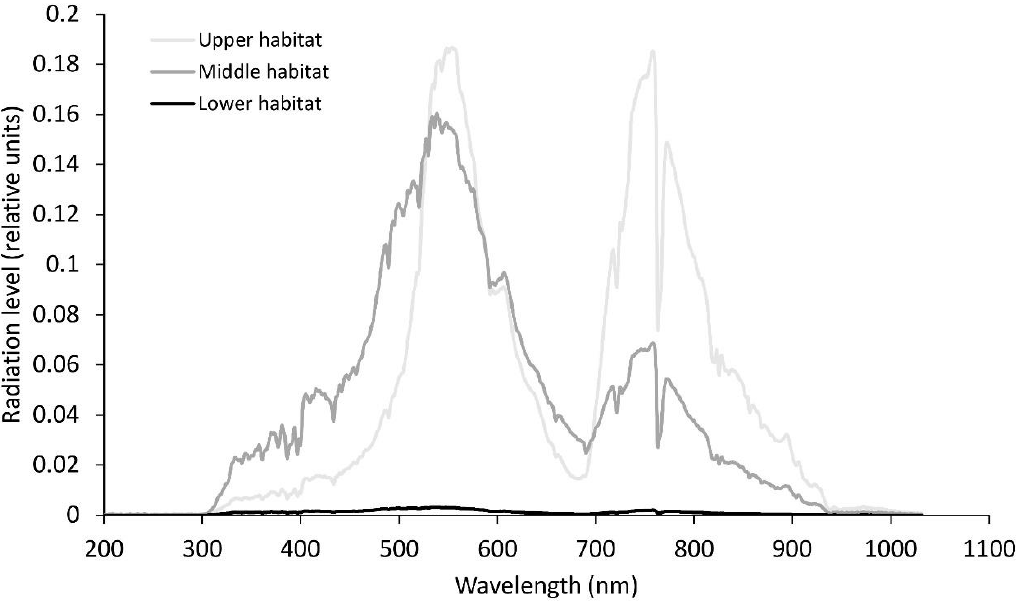
Figure 2. Relative solar radiation levels at noon-time for the different wavelengths for the three habitats in June. Average photosynthetically active radiation in the upper habitat, 158 µmol m −2 s −1 ; middle habitat, 125 µmol m −2 s −1 ; lower habitat, 2 µmol m −2 s −1 .